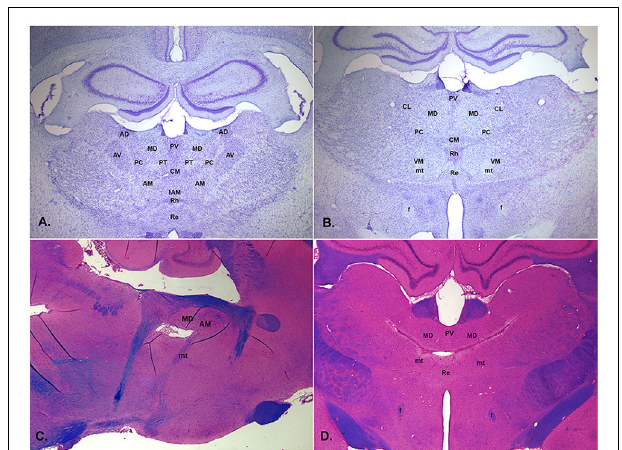
FIGURE 1 | Low magnification photomicrographs of central thalamus showing normal appearance of coronal sections stained with thionin approximately 2.3 mm (A) and 2.8 mm (B) posterior to bregma and thalamic lesions from the post-thiamine deficiency (PTD) model of the Wernicke-Korsakoff syndrome (WKS) stained with luxol blue, hematoxylin, and eosin in the sagittal section about 0.9 mm off midline ( C , tissue from Mair et al., 1988) and in the coronal section about 3.2 mm posterior to bregma ( D , tissue from Mair et al., 1991). PTD treatment produces bilaterally symmetric lesions centered on the mediodorsal (MD) and intralaminar nuclei that tend to spare the anterior nuclei. It is associated with behavioral impairments consistent with the performance of WKS patients on comparative neuropsychological tasks (Mair, 1994). Labeled structures include the MD, centrolateral (CL), paracentral (PC), central medial (CM), reuniens (Re), rhomboid (Rh), ventromedial (VM), anterodorsal (AD), anteromedial (AM), anteroventral (AV), interanteromedial (IAM), and paratenial (PT) nuclei and the fornix (f) and mammillothalamic tract